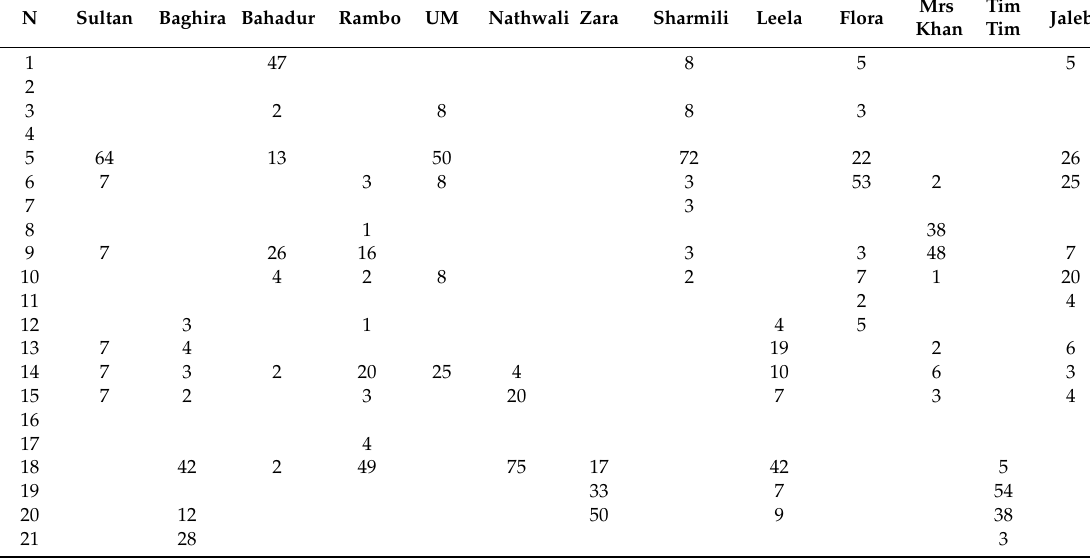
Table 2. Percentage of photographs at camera stations for the 11 leopards whose home ranges are estimated with a confidence of reliability. (N = Camera Station Number, UM = Unidentified Male